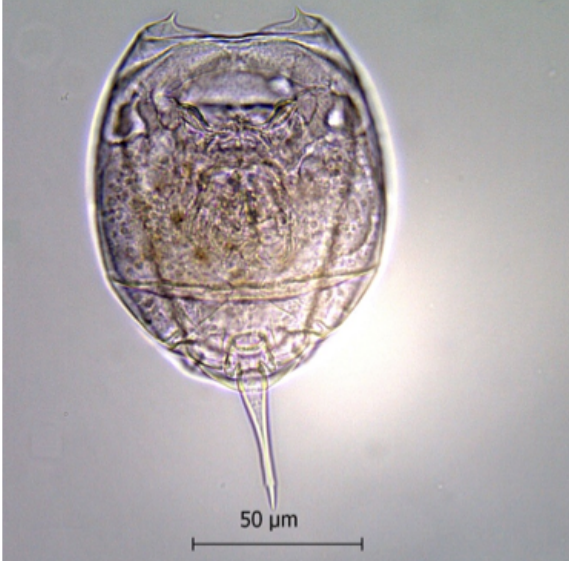
Image 8. Lecane stenroosi (Meissner), dorsal